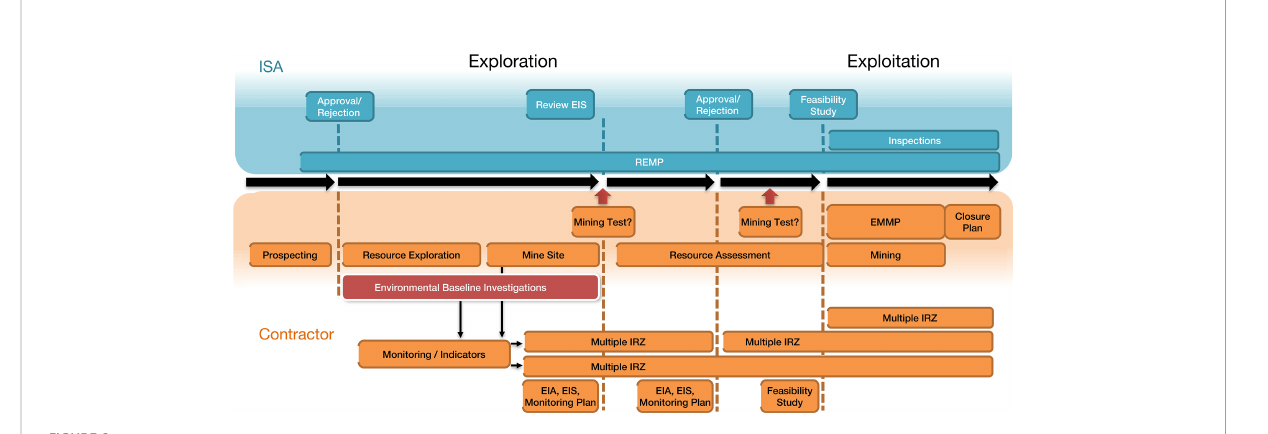
FIGURE 2 The key role of baseline research for environmental management by the